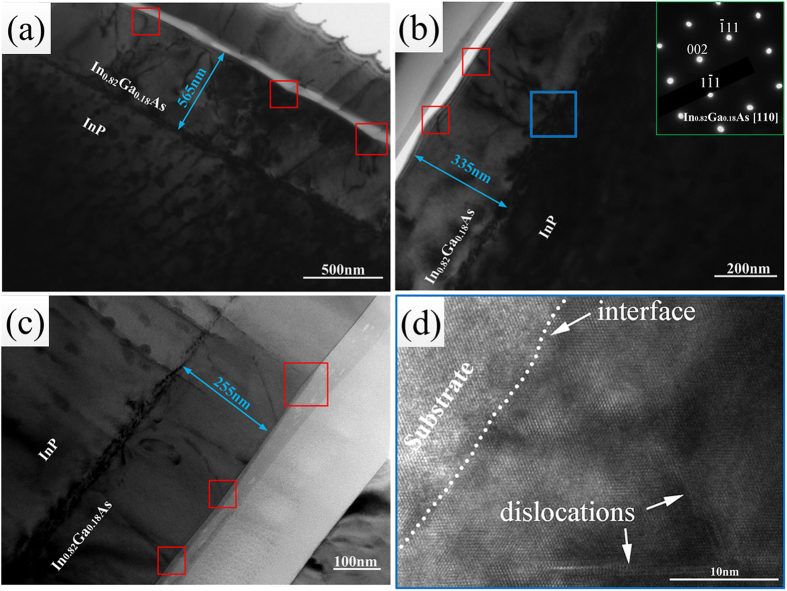
Cross-sectional views of the In0.82Ga0.18As/InP epitaxial layers for the [110] zone which were deposited simultaneously and at different preparation temperatures: (a) 430 °C; (b) 410 °C; (c) 390 °C.